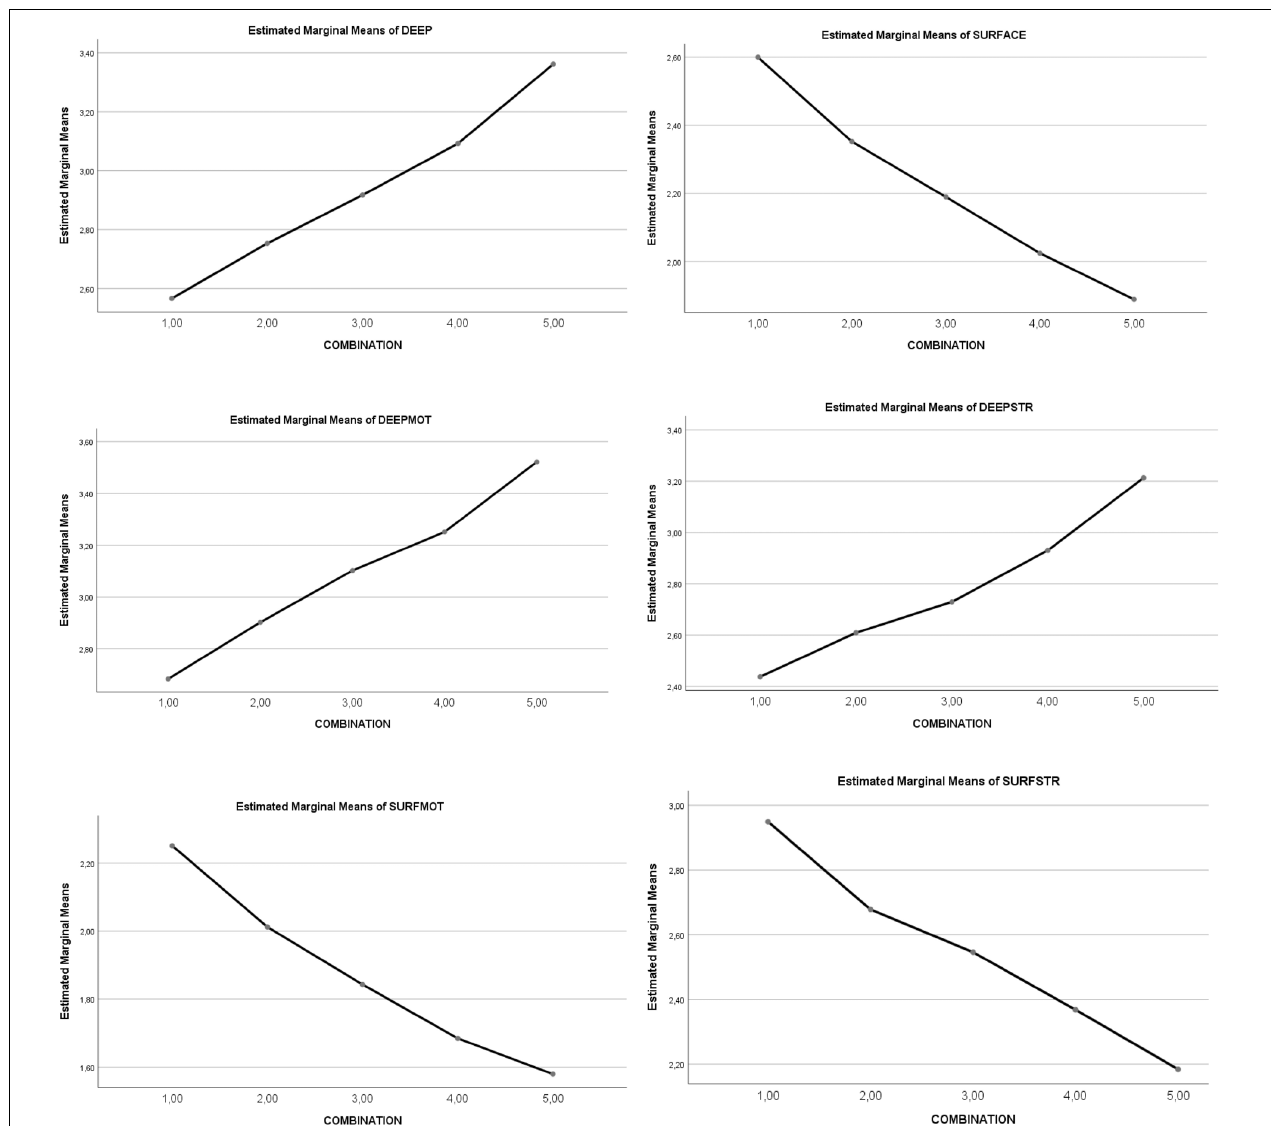
FIGURE 3 | Graphical representation of the effects of the combination types (heuristic levels 1–5) on learning